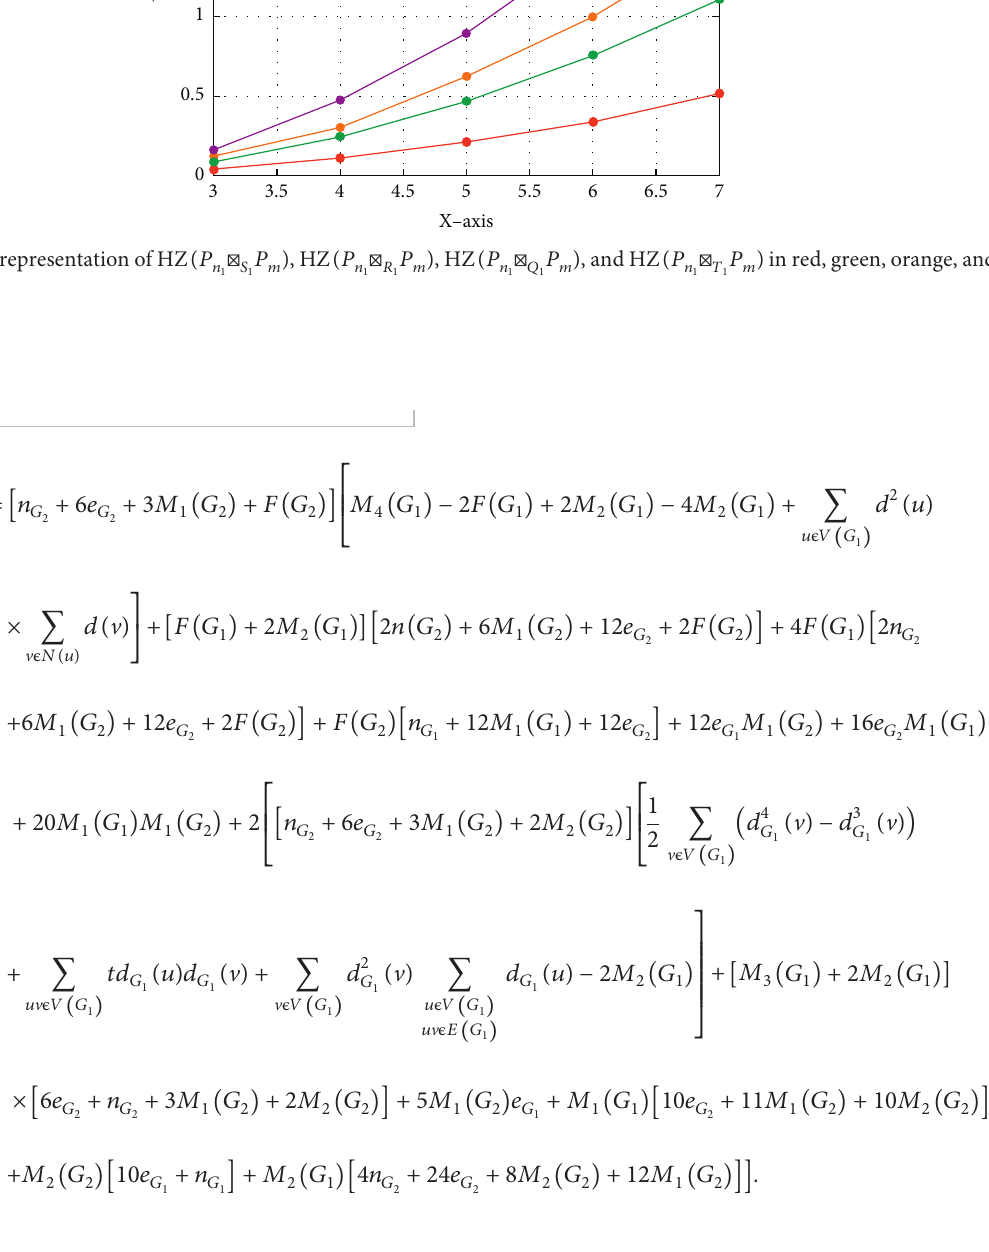
P ) in red, green, orange, and purple n 1 ⊠ T 1 m